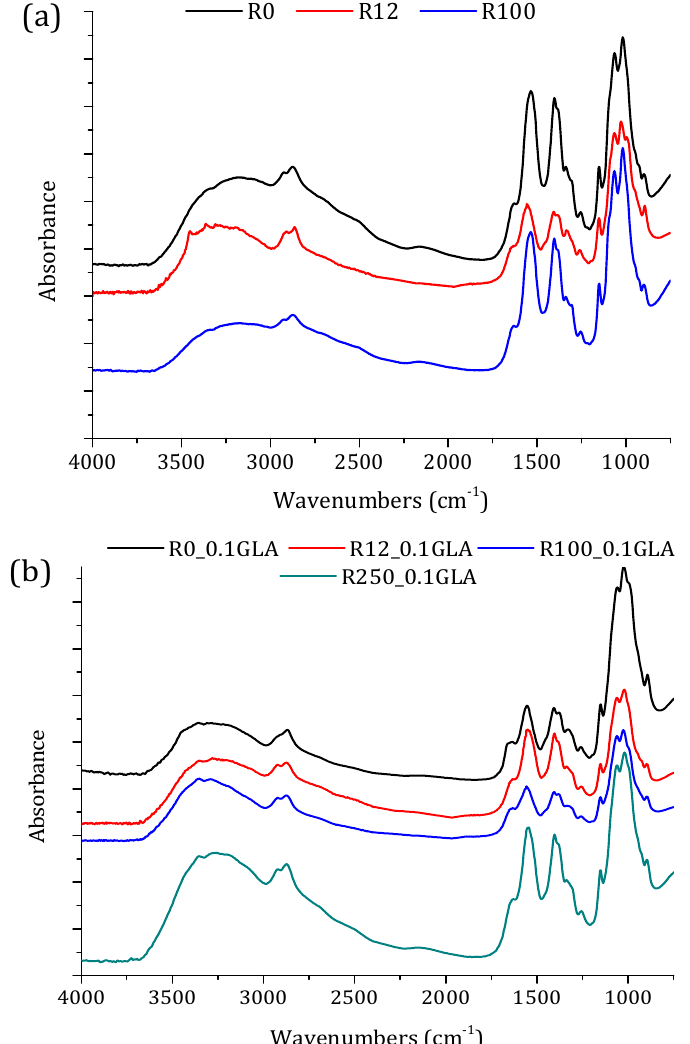
Figure 6. FTIR-ATR spectra of the membranes prepared with non-irradiated and irradiated chitosan at different doses: ( a ) without GLA and ( b ) with 0.1 wt % GLA in the chitosan solution.